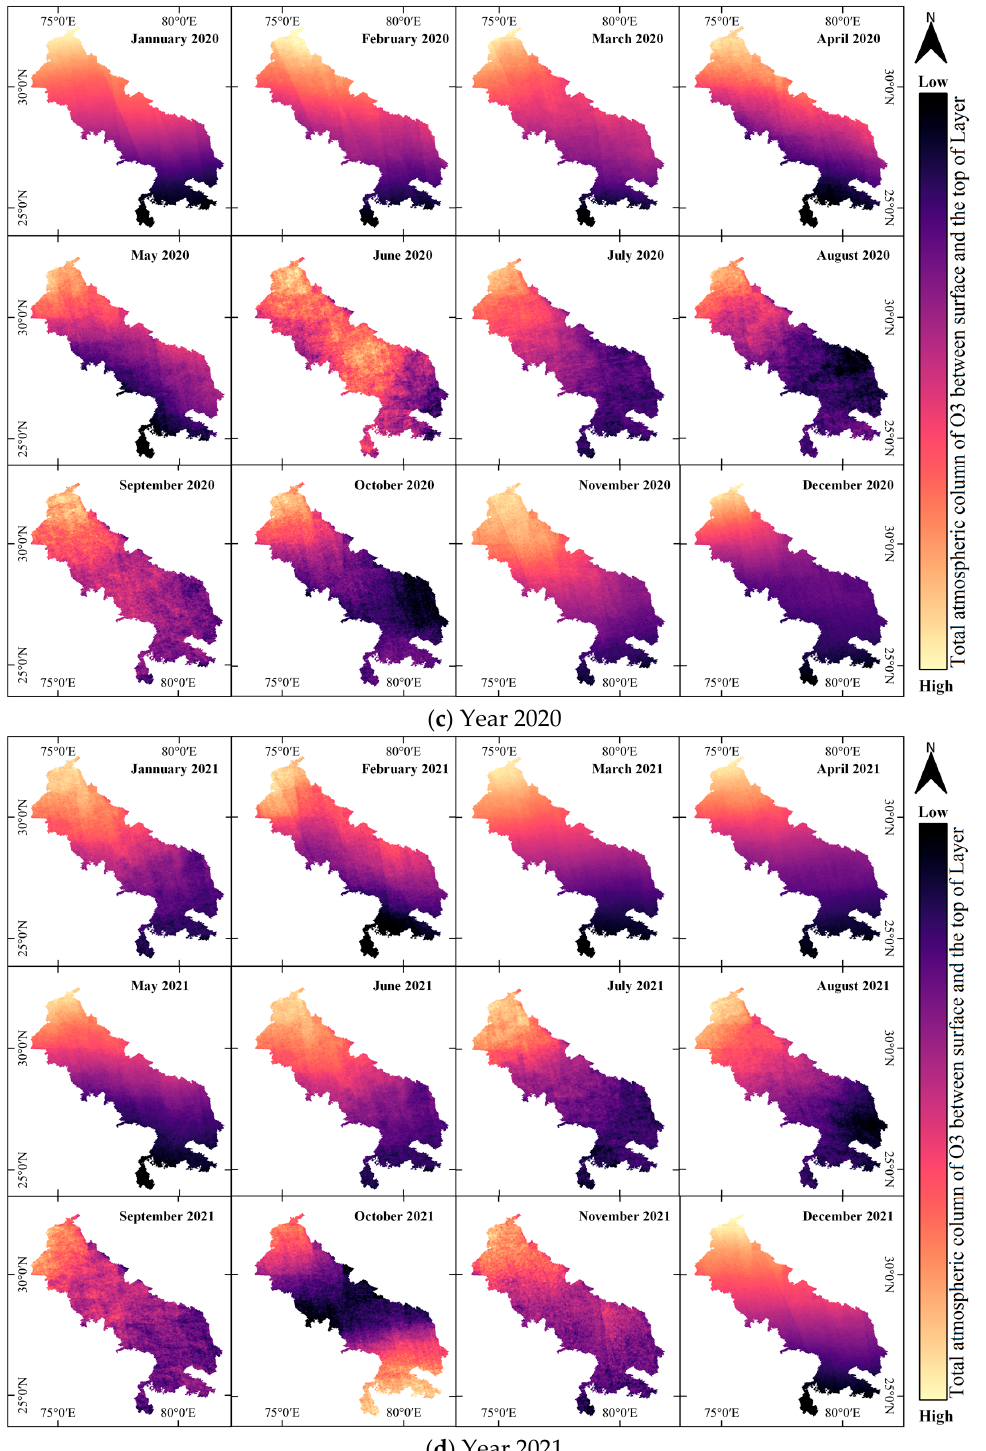
Figure 10. Atmospheric O 3 concentration over the study site (based on data availability September 2018 to December 2021).